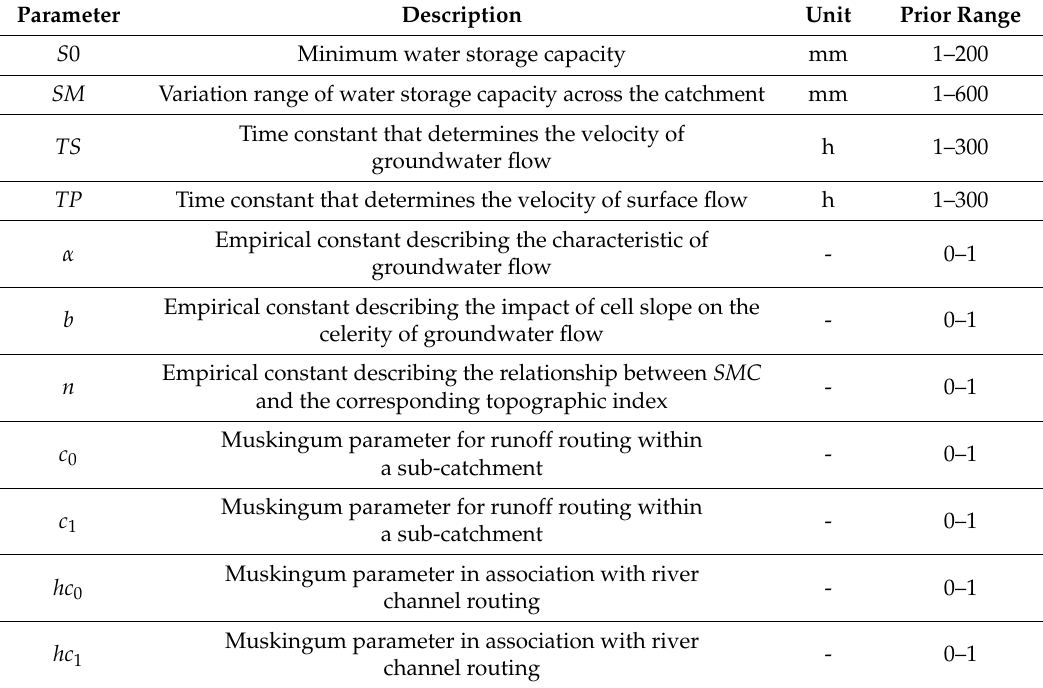
Table 1. Descriptions of the DEM-based distributed rainfall-runoff mode (DDRM)